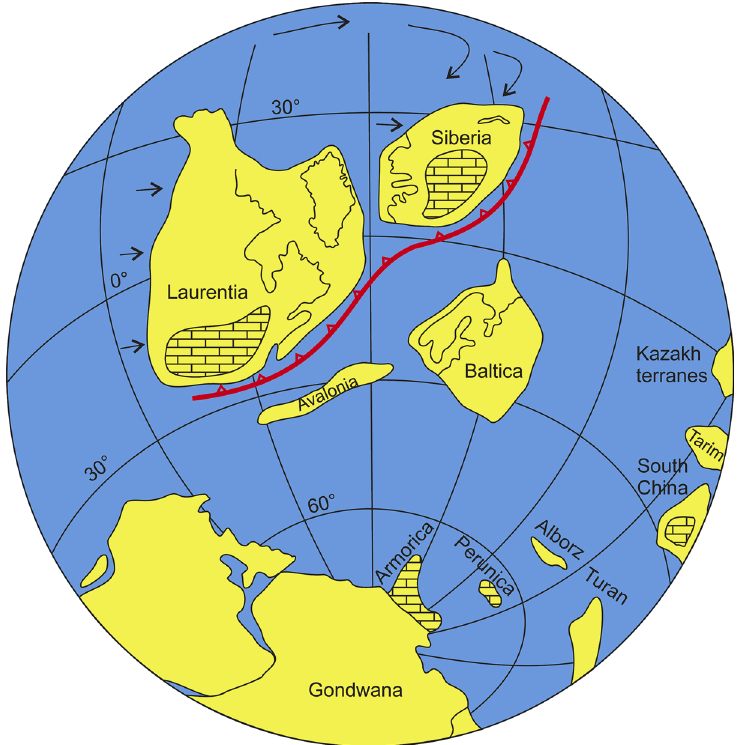
Fig. 4. Proposed paleogeographic reconstruction of the Late Ordovician showing a continuous subduction zone along the Laurentian and Siberian Platform